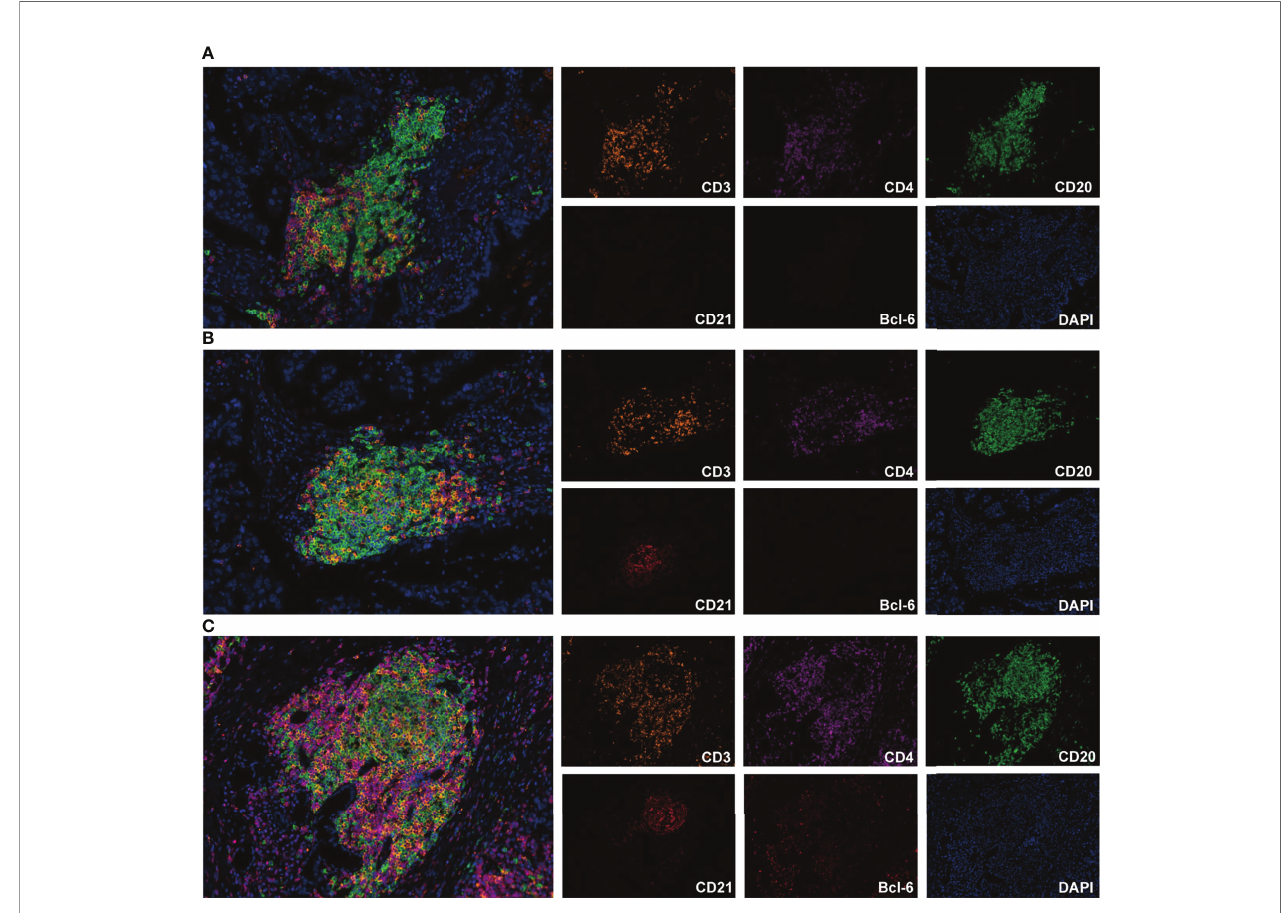
FIGURE 1 | Representative images of TLS maturity (magni fi cation, ×200). The slide was stained with CD3 (orange), CD4 (purple), CD20 (green), CD21 (brown), Bcl- 6 (red), and DAPI (blue). (A) , E-TLS, both FDC and Bcl-6 markers were negative. (B) , PFL-TLS, FDC positive and Bcl-6 negative. (C) , SFL-TLS, both FDC and Bcl-6 markers were